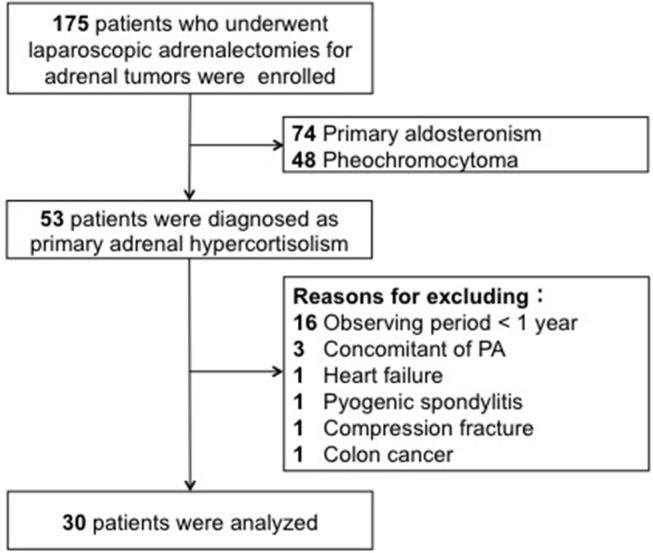
The patients who underwent laparoscopic adorenalectomy were enrolled. Of those, 53 patients were diagnosed as primary adrenal hypercortisolism. Twenty-three patients were excluded from the analysis due to a short follow-up period, severe pre-existing complications, and the simultaneous presence of aldosteronism.